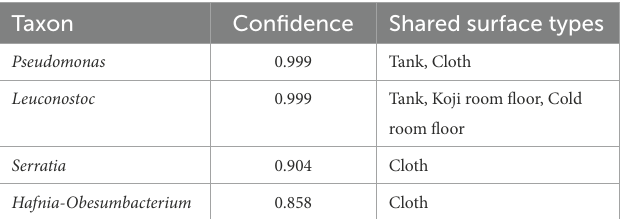
TABLE 2 The taxon of shared ASV (Genus-level) between Moto on Day 33 and other